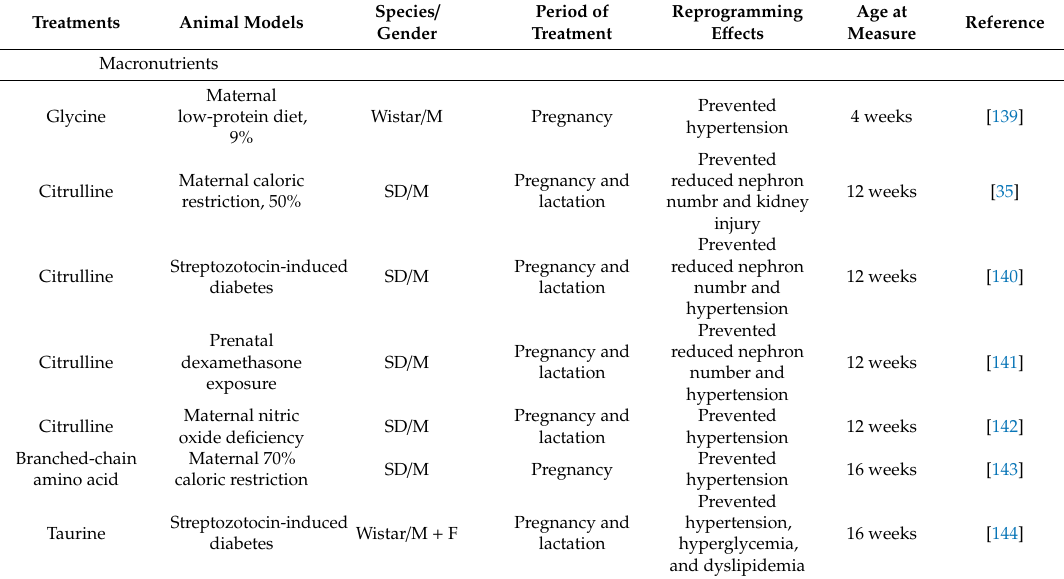
Table 2. Reprogramming strategies aimed at nutritional interventions to prevent developmental programming of adult diseases in animal